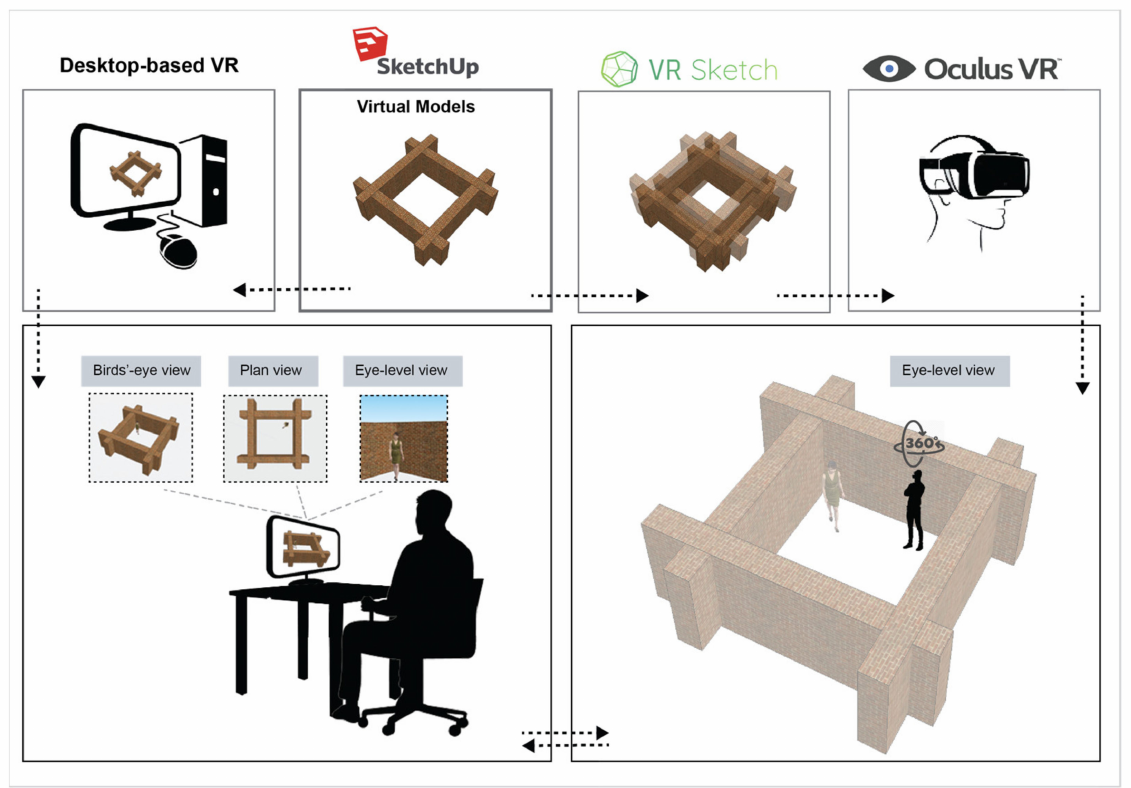
Figure 2. Experiment setup schema and view types used in each system.